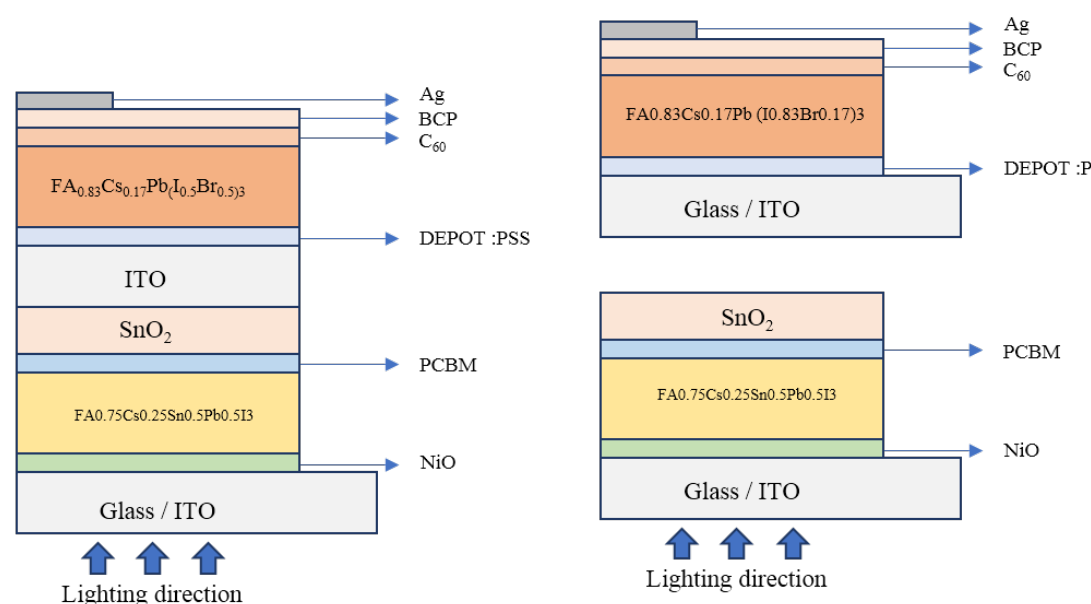
Figure 10: Monolithic and four-terminal Perovskite / Perovskite tandem cell are presented